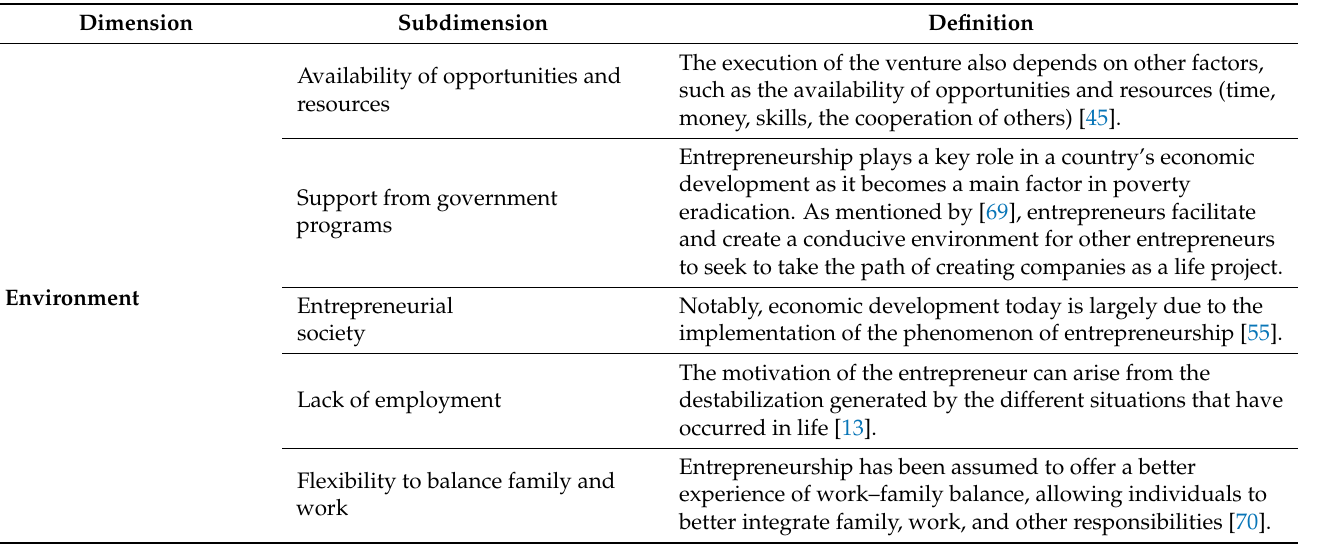
Table 4. The environmental